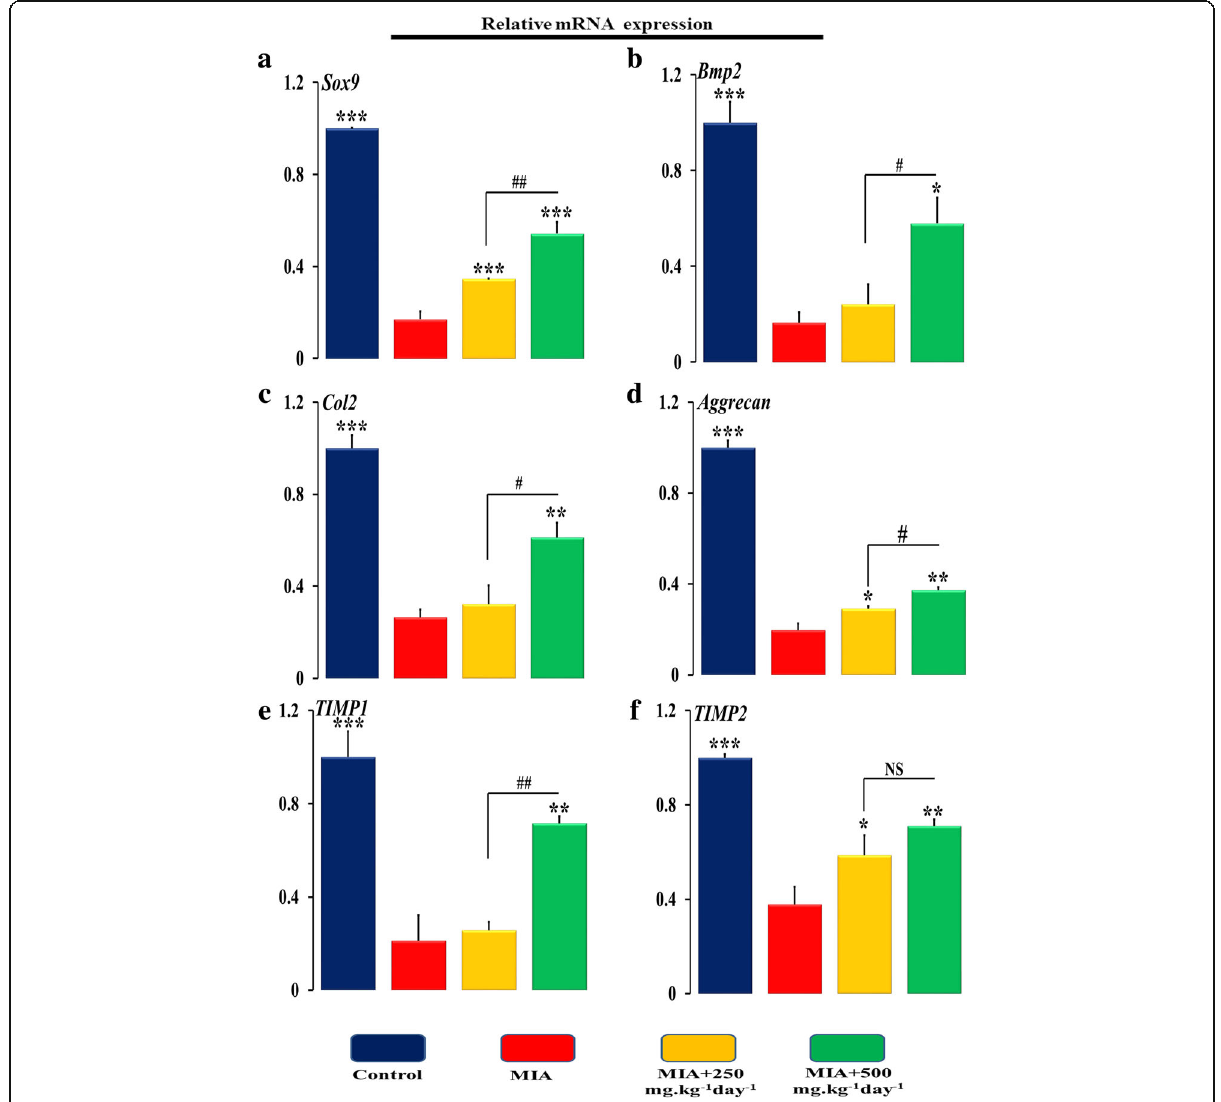
Fig. 7 SOE increases MIA inhibited chondrogenic marker gene expression. qPCR determination of mRNA levels of chondrogenic genes ( a ) Sox9, ( b ) Bmp2, ( c ) Col2a, ( d ) Aggrecan, ( e ) TIMP-1 and ( f ) TIMP-2 in isolated bone region which contain cartilage and sub-chondral bone. All values are expressed as Mean ± S.E.M. ( n = 6/group); * P < 0.05, ** P < 0.01, *** P < 0.001 compared to the MIA group # P < 0.05, ## P < 0.01, compared to